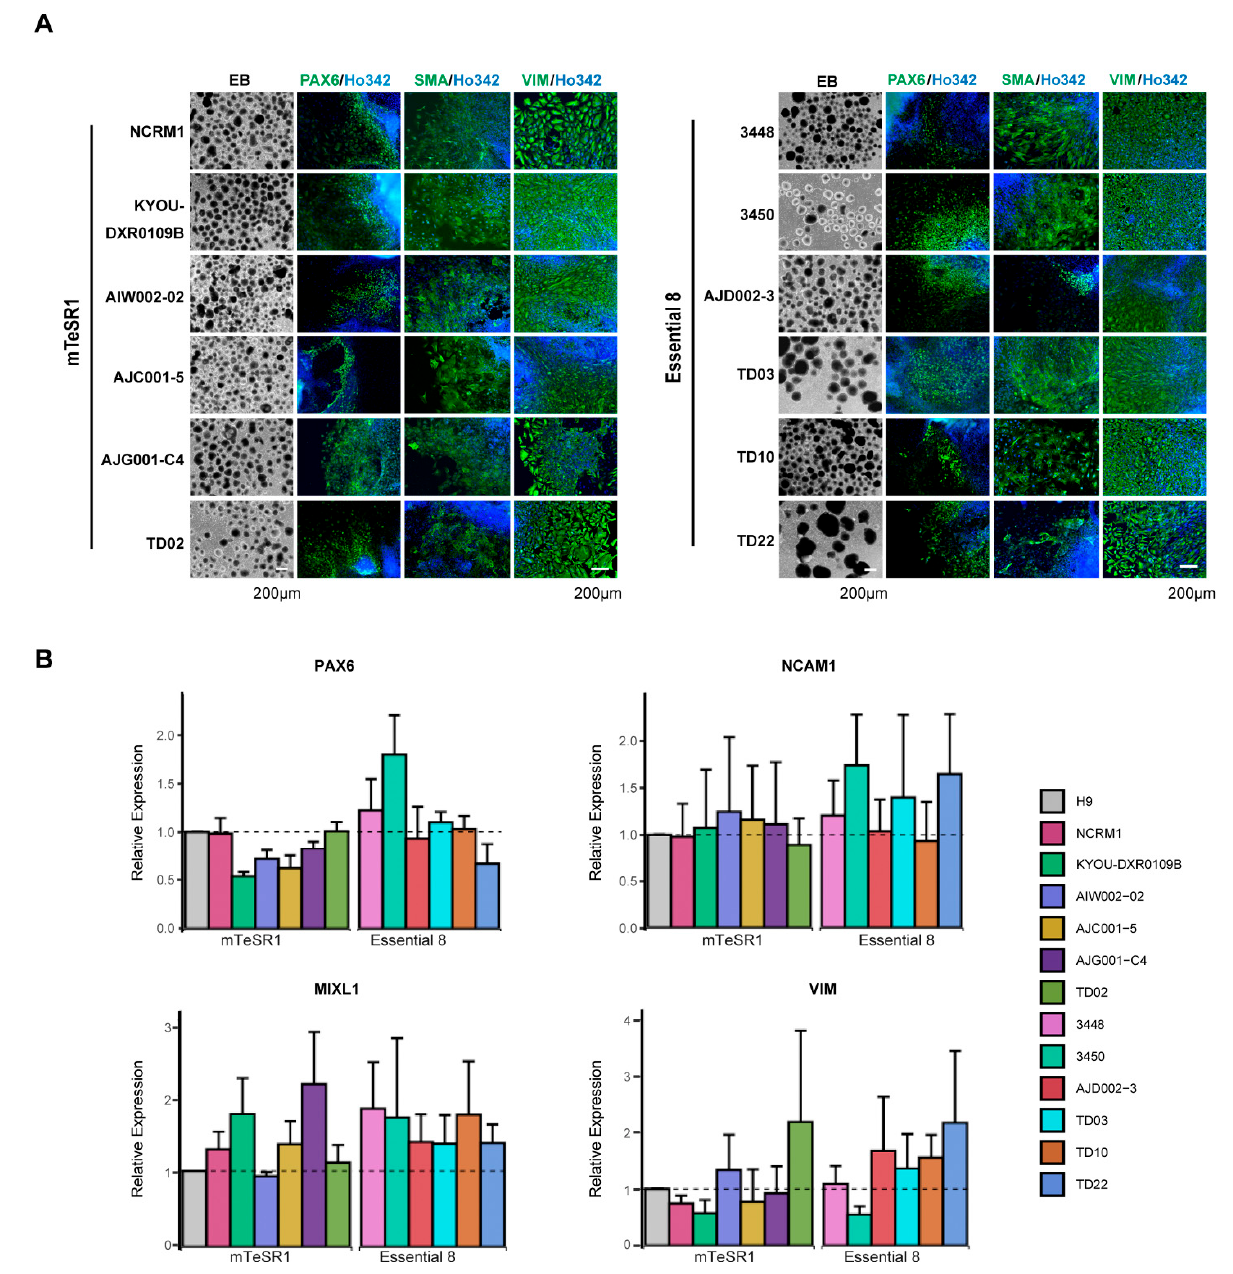
Figure 5. Differentiation of hiPSCs into three germ layers. ( A ) Representative phase contrast images of EB formation (left) and differentiation into three germ layers by ICC with the ectoderm (PAX6), mesoderm (SMA), and endoderm (VIM) markers (indicated above images). Nuclei are counterstained with Ho342. ( B ) qPCR for mRNA expression of three germ layer genes. Quantification of expression of the ectoderm (PAX6, NCAM1), mesoderm (MIXL1), and endoderm (VIM) markers in hiPSCs compared to H9 ESC. mRNA expression in H9 was set as 1.0. The mean and SD are from technical triplicates from three independent experiments.